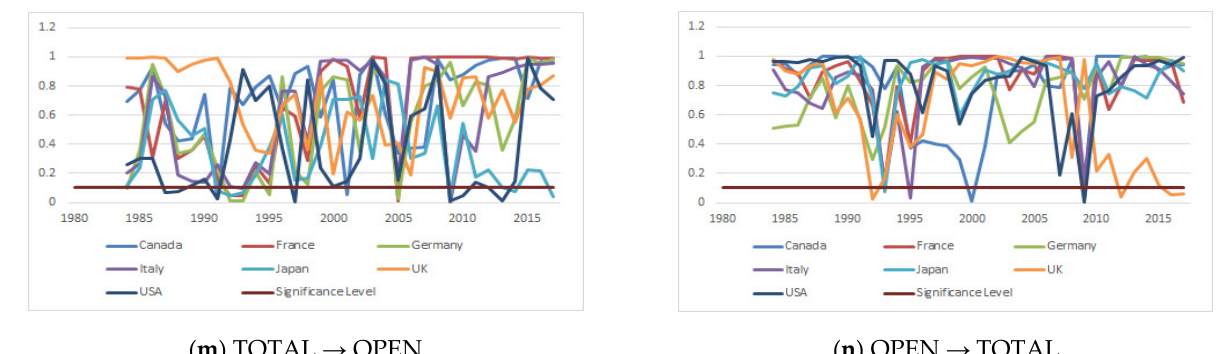
Figure 3. The results of the asymmetric panel causality test for negative shocks.